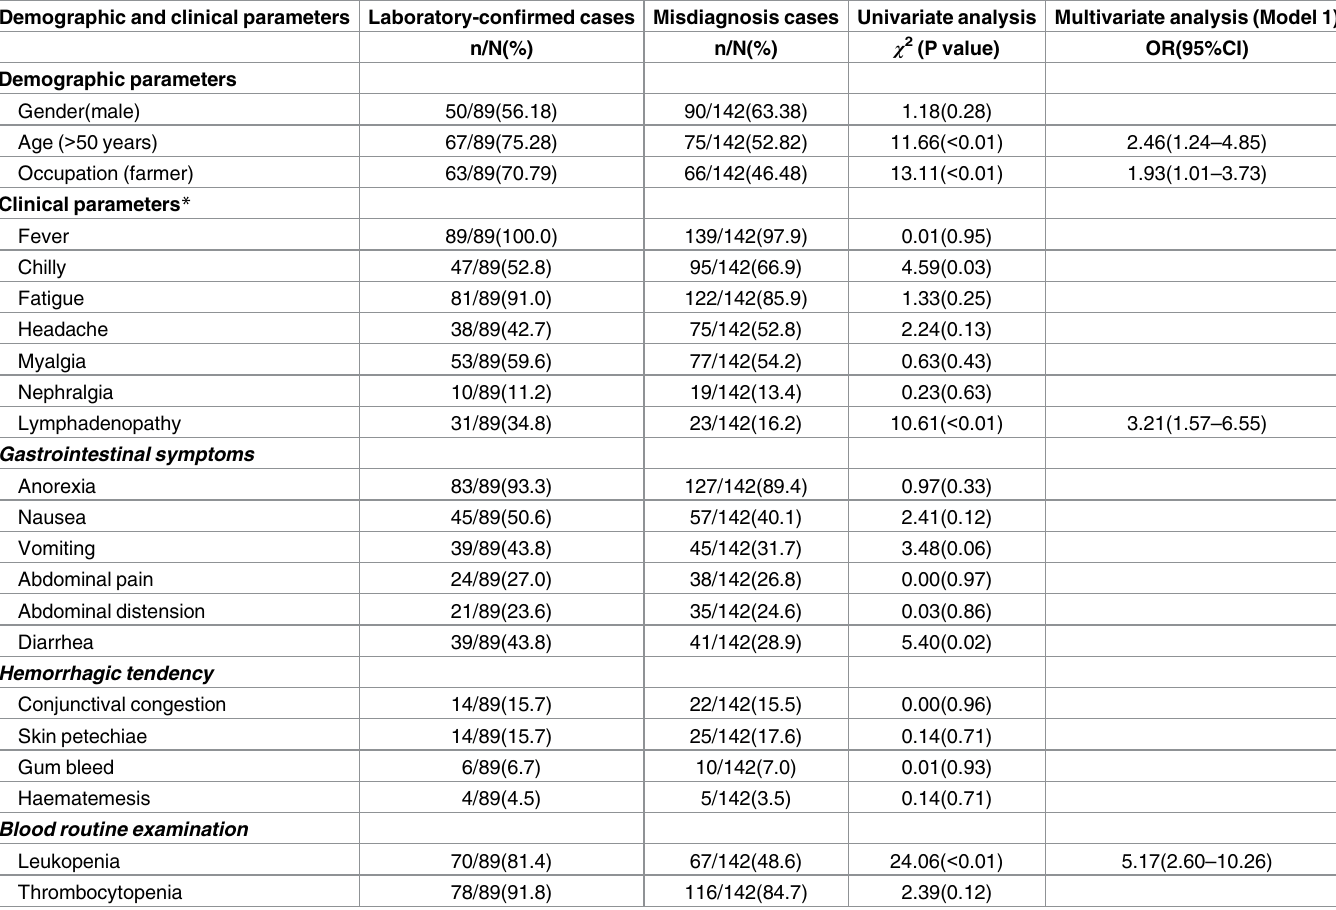
Table 1. Demographic and clinical parameters of laboratory-confirmed cases and misdiagnosis cases in Jiangsu Province, China, 2011–2013. Demographic and clinical parameters Laboratory-confirmed cases Misdiagnosis cases Univariate analysis Multivariate analysis (Model